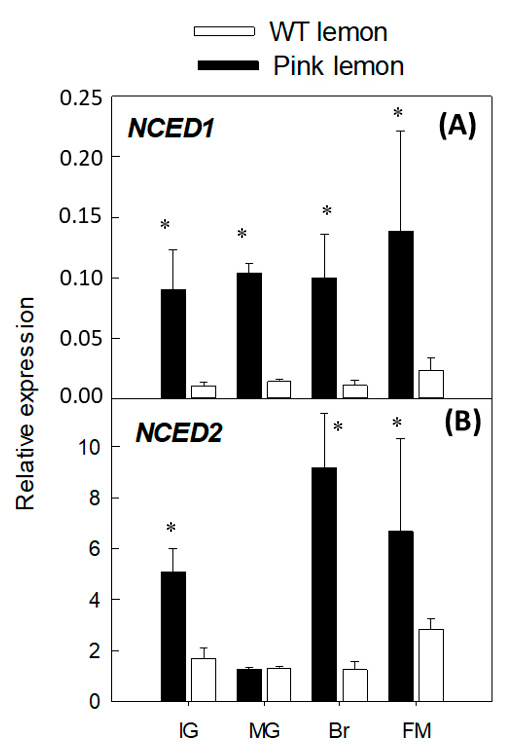
Figure 5. Changes in the expression of genes involved in abscisic acid biosynthesis: NCED1 , 9-cis-epoxy-carotenoid dioxygenase 1 ( A ); NCED2 , 9-cis-epoxy-carotenoid dioxygenase 2 ( B ), in the pulp of the PL and WT lemon fruit at four developmental stages: IG (immature green), MG (mature green), BR (breaker), FM (fully mature). Asterisks indicate significant differences between genotypes for each developmental stage ( p < 0.01) by one-way ANOVA ( p < 0.01).